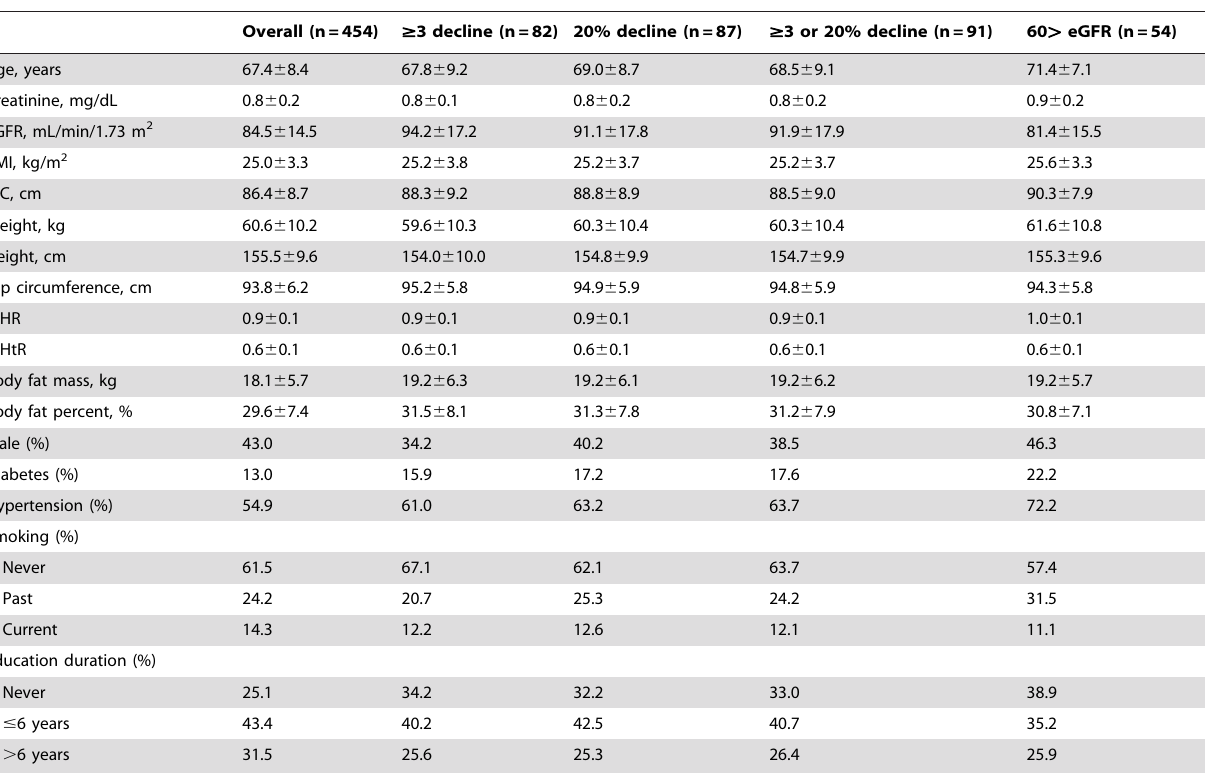
Table 1. Baseline characteristic of participants and cases according to renal function decline in the HAS in Korea, 2004.